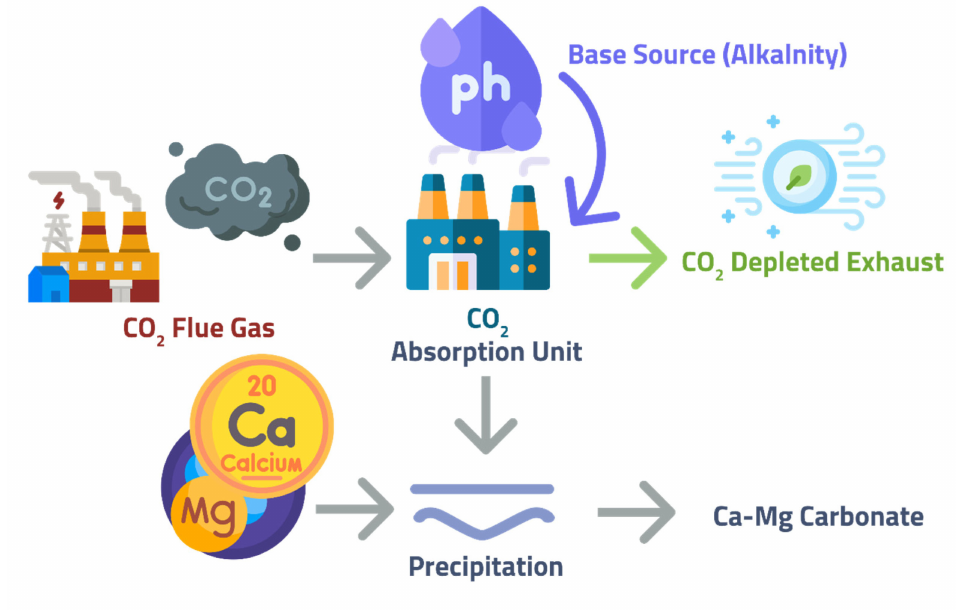
Figure 8. Schematic Diagram for Calera Process, adapted from Sanna et al.